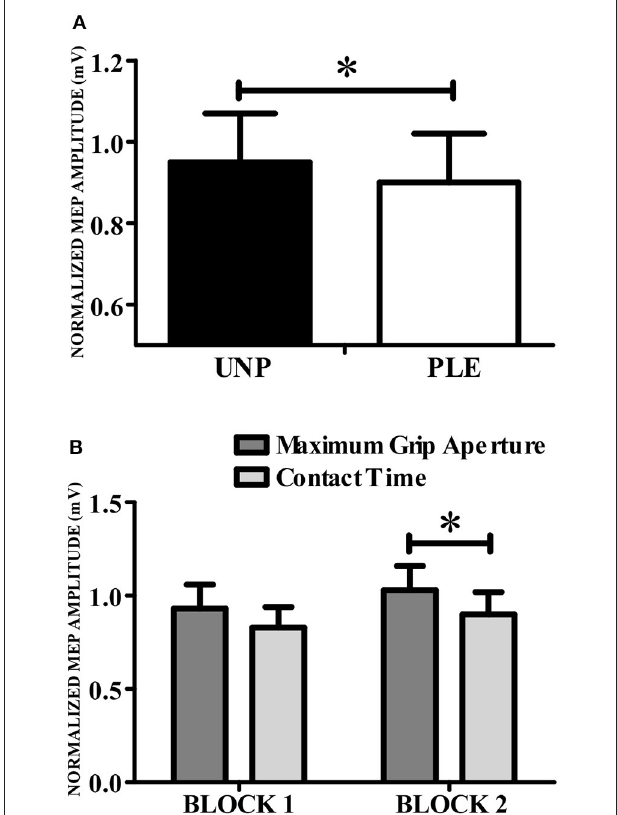
FIGURE 4 | Corticospinal excitability. (A) CSE was higher during the observation of grasping directed to unpleasant (black bars) compared to pleasant (white bars) objects. (B) CSE was higher for grip aperture than for contact time. UNP, unpleasant; PLE, pleasant (* p < 0.05).